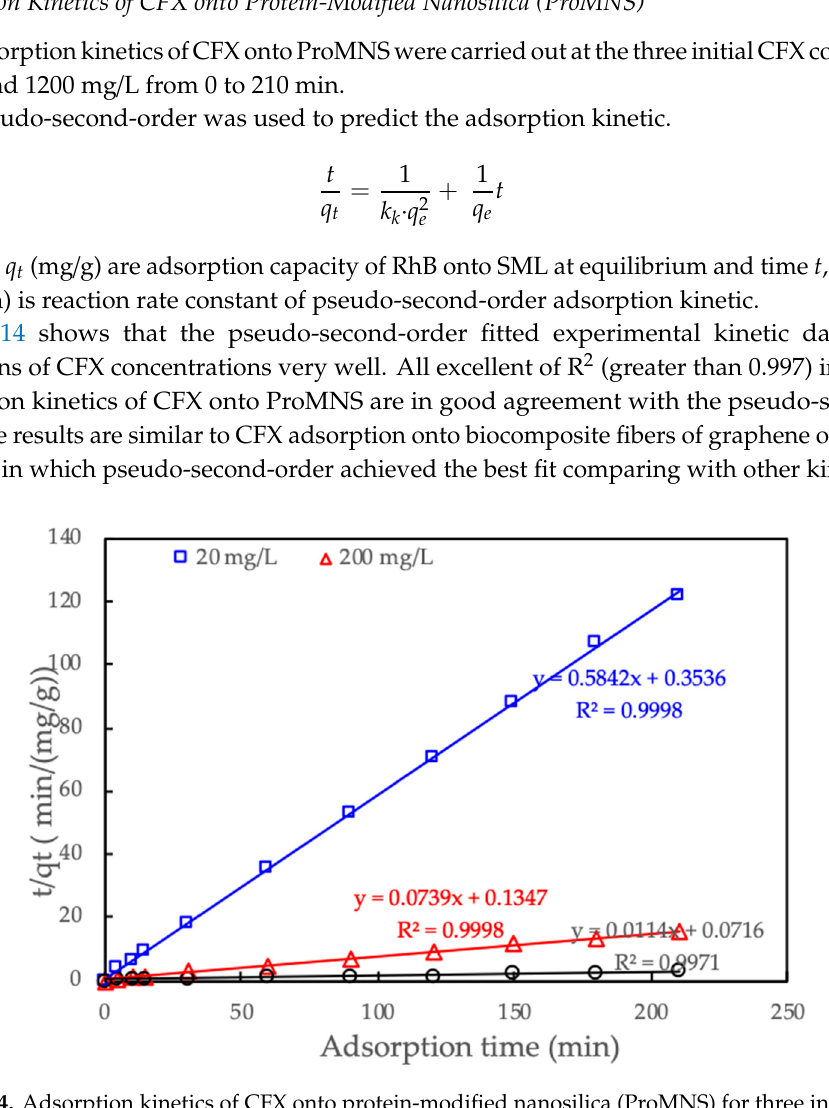
Figure 14. Adsorption kinetics of CFX onto protein-modified nanosilica (ProMNS) for three initial CFX concentrations. Points are experimental results and solid lines are fitted by pseudo-second-order model.